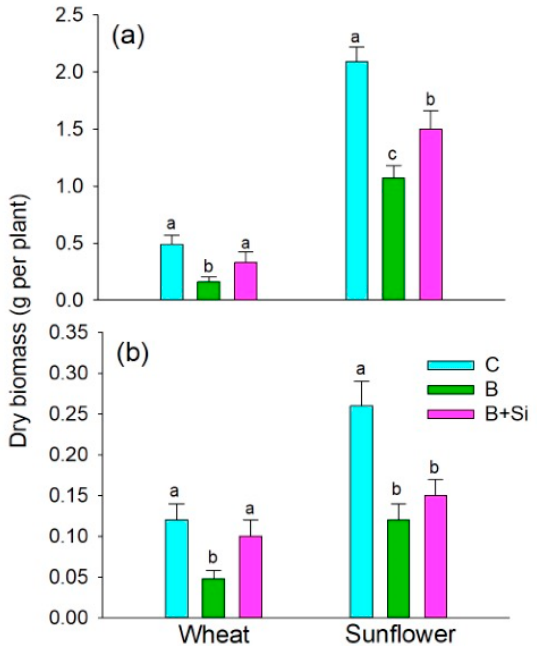
Figure 1. Dry shoot ( a ) and root ( b ) biomass of sun fl ower and wheat plants. Plants were grown for 14 d in the following treatments: C (control; 1 µM B for wheat and 10 µM B for sun fl ower), B (500 µM B), and B + Si (500 µM B + 1.5 mM Si). Data are means ± SD (n = 4). Statistically signi fi cant di ff erences between treatments for each crop ( p < 0.05, Tukey’s test) are indicated by di ff erent le tt ers.